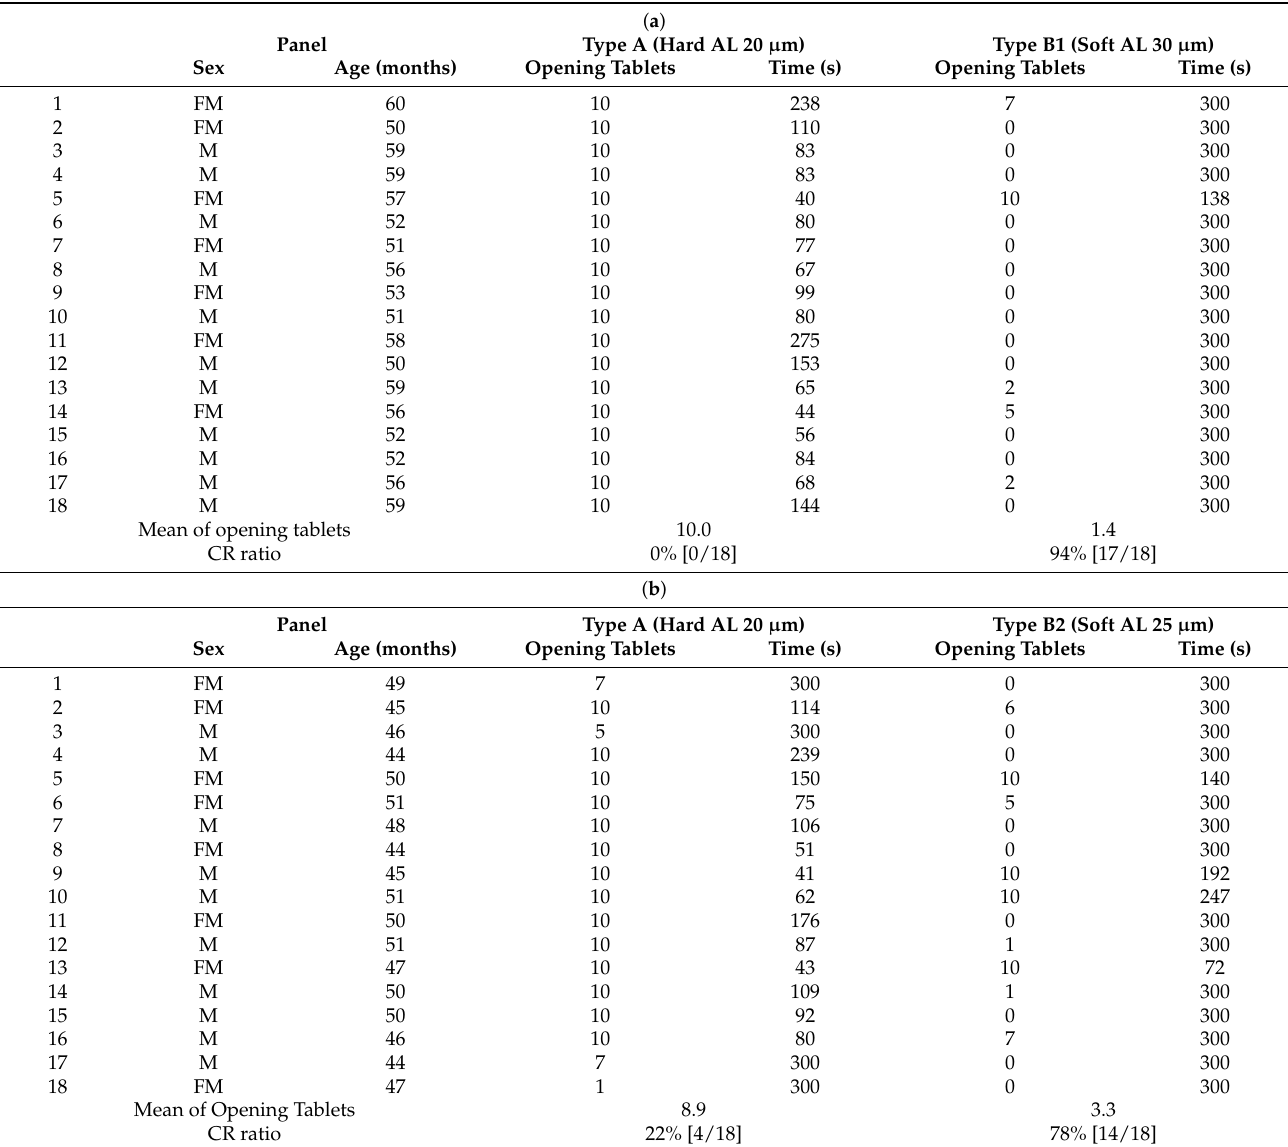
Table 3. ( a ) CR Child Test-1 (Type B1). ( b ) CR Child Test-2 (Type B2).